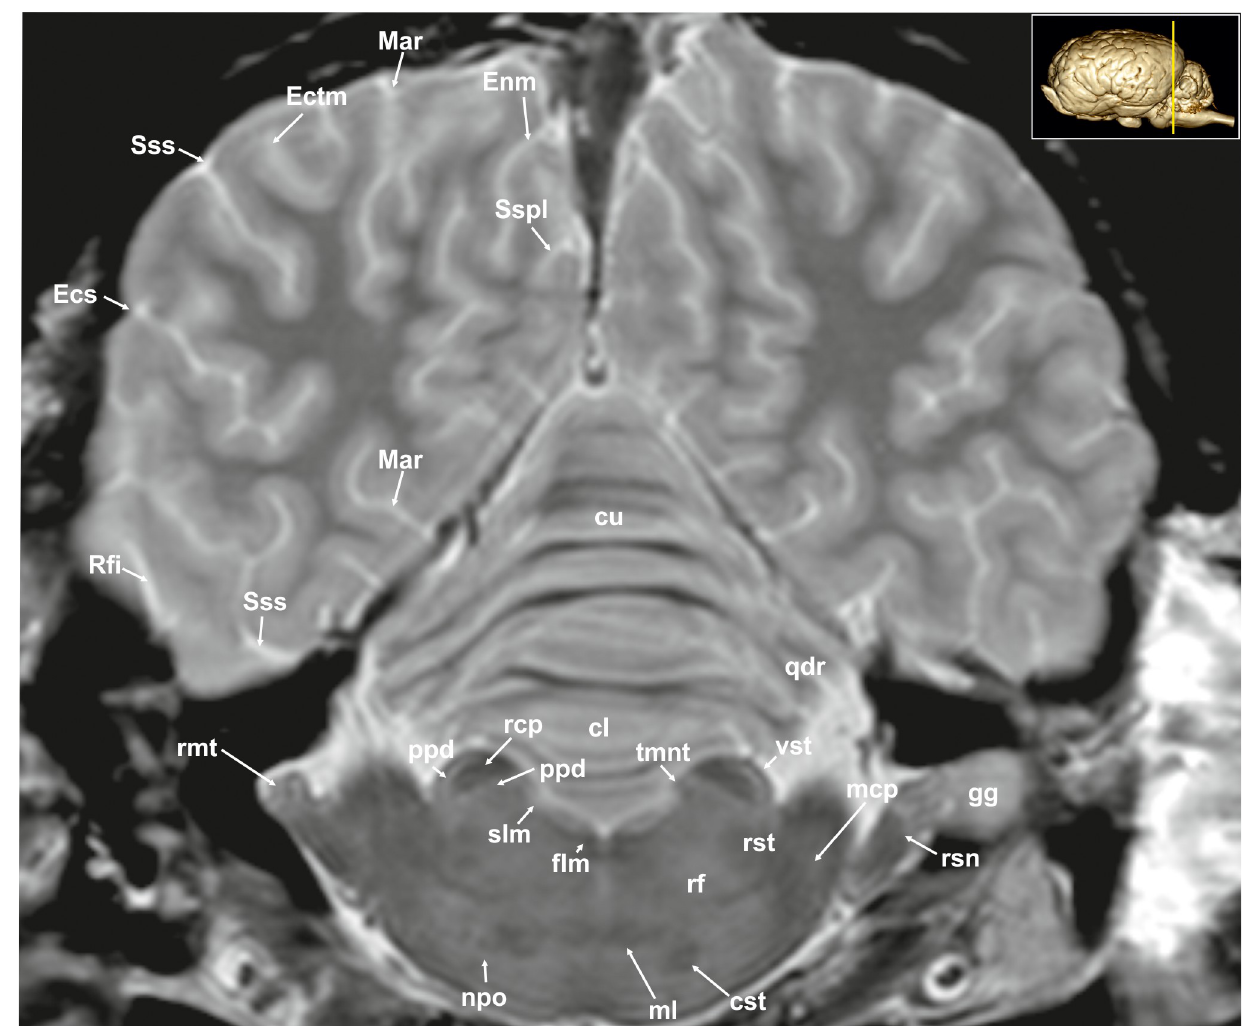
Fig 12. Transverse magnetic resonance image of the equine brain on the level of the rostral cerebellar peduncle. cl: central lobule, cst: corticospinal tract, cu: culmen, Ecs: ectosylvian sulcus, Ectm: ectomarginal sulcus, Enm: endomarginal sulcus, flm: medial longitudinal fasciculus, gg: Gasserian ganglion, Mar: marginal sulcus, mcp: medial cerebellar peduncle, ml: medial lemniscus, npo: nuclei of the pons, ppd: parapeduncular nuclei, qdr: quadrangulare lobule, rcp: rostral cerebellar peduncle, rf: reticular formation, Rfi: rhinal fissure, rmt: radix motoria of the trigeminal nerve, rsn: radix sensoria of the trigeminal nerve, rst: rubrospinal tract, Sspl: suprasplenial sulcus, Sss: suprasylvian sulcus, tmnt: mesencephalic tract of the trigeminal nerve, vst: vestibulospinal tract.